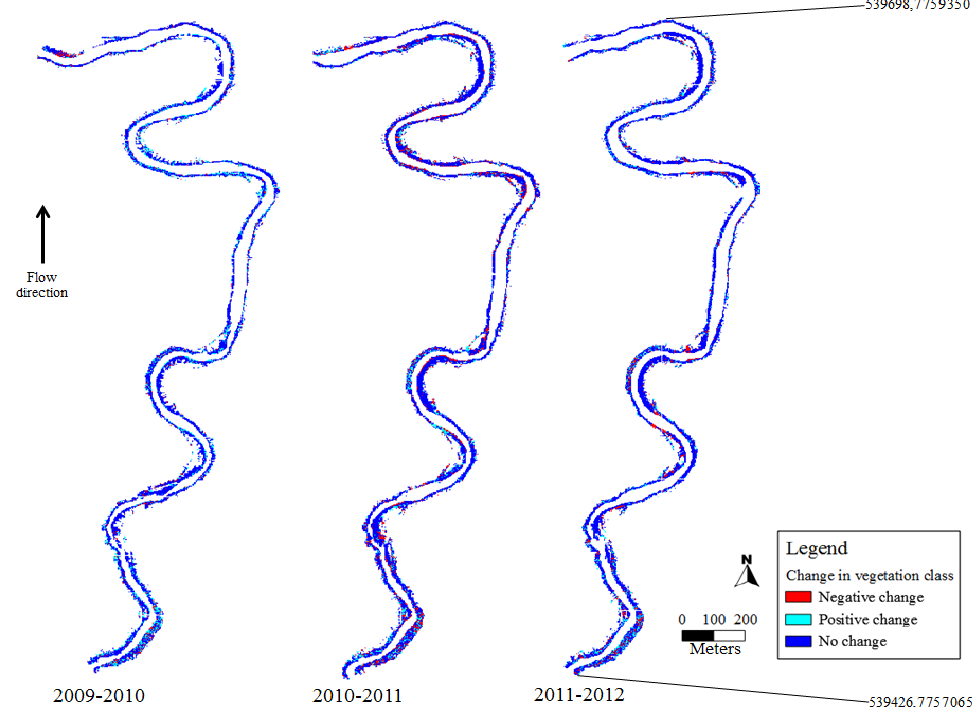
Figure 7. Changes in vegetation classes associated with erosion or damage (negative change) and vegetative growth (positive change) in different years. Coordinates of